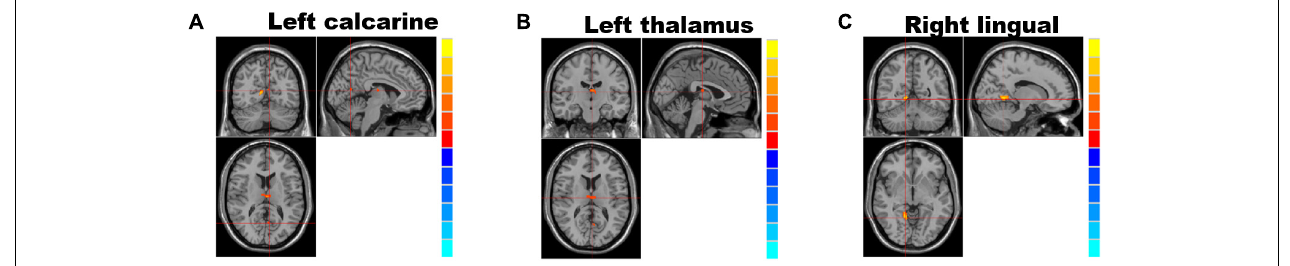
FIGURE 1 | Brain regions showing significantly decreased gray matter volume and group differences (table below) between individuals with neuromyelitis optica spectrum disorder (NMOSD) and controls; from left to right: left calcarine gyrus (A) , the left thalamus (B) , and right lingual gyrus (C) . ( P < 0.05, threshold-free cluster enhancement (TFCE) correction). The gray matter volumes in the left calcarine gyrus (A) , left thalamus (B) , and right lingual gyrus (C) were significantly reduced ( P < 0.05) in NMOSD patients when compared to